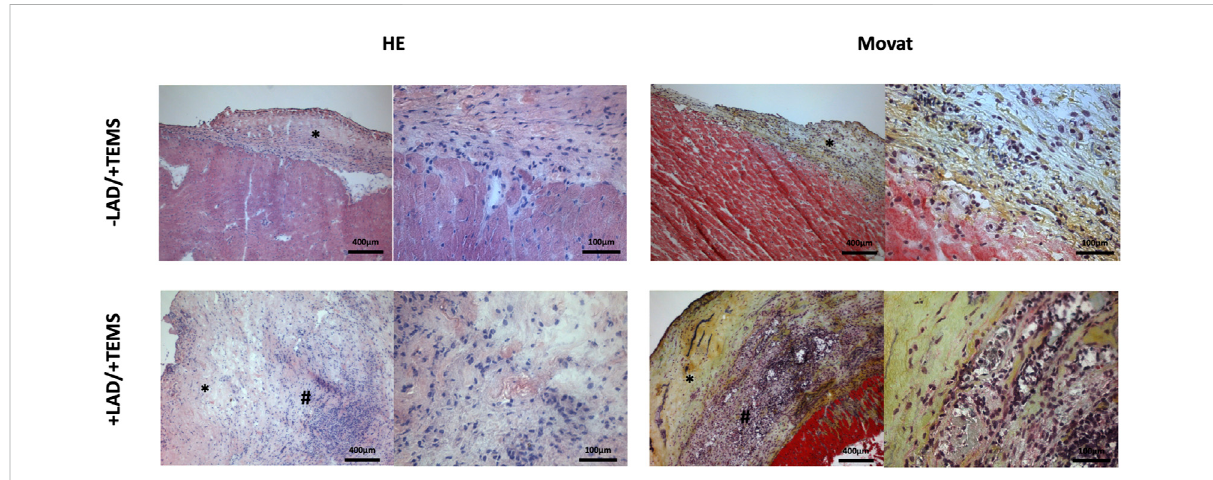
FIGURE 4 Orientating histological analysis.RepresentativeimagesofHEandMOVATstainingofexplantedhearts4weeksafterventricularstabilizationvia TEMS implantation with and without prior myocardial infarction via LAD-ligature, showing high degree of cellular in fi ltration of the TEMS scaffold (*) as well as integration of the TEMS scaffold into the infarcted zone (#) of the heart.